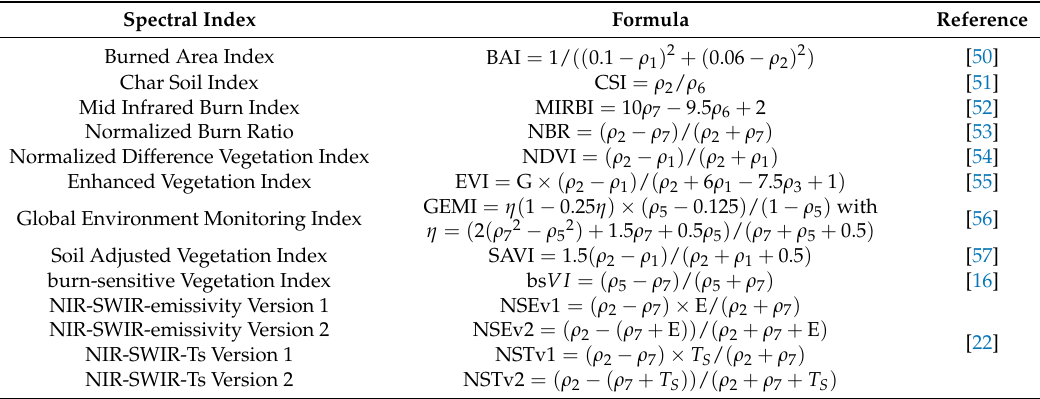
Table 4. Formula of the spectral indices used and corresponding